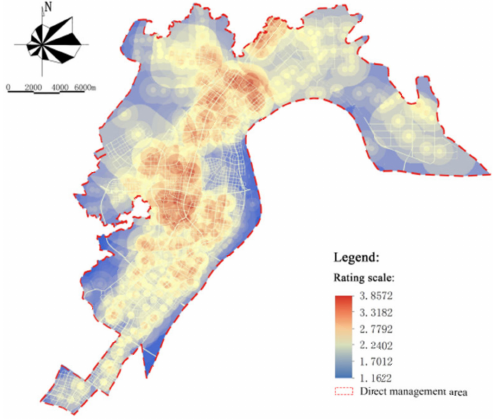
Figure 10. Comprehensive assessment diagram of site selection influential elements of affordable